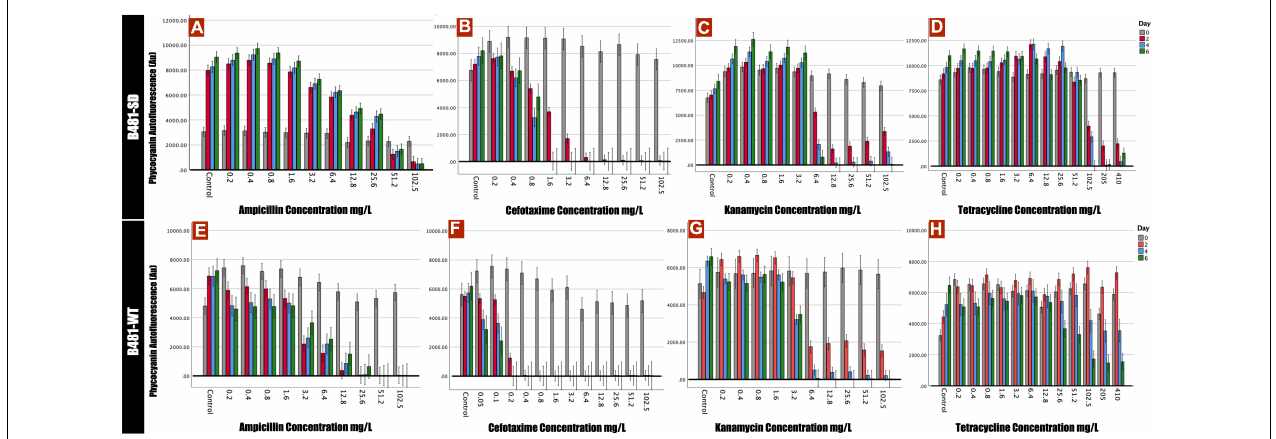
FIGURE 1 | Phycocyanin autofluorescense of B481-SD and B481-WT strains reflected by 590 nm excitation and 650 nm emission. B481-SD strain was exposed to concentrations ranging from 0.2 to 102.5 mg/L ampicillin, cefotaxime, kanamycin, and tetracycline (A–D) , and B481-WT strain to ampicillin and kanamycin concentrations ranging from 0.2 to 102.5 mg/L; 0.05–102.5 mg/L for cefotaxime and 0.2–410 mg/L for tetracycline (E–H) . Both strains were cultivated in antibiotics for 6 days at 28 ◦ C with a light intensity of 30 µ mol m - 2 s − 1 . Mean and standard deviations are indicated by error bars.